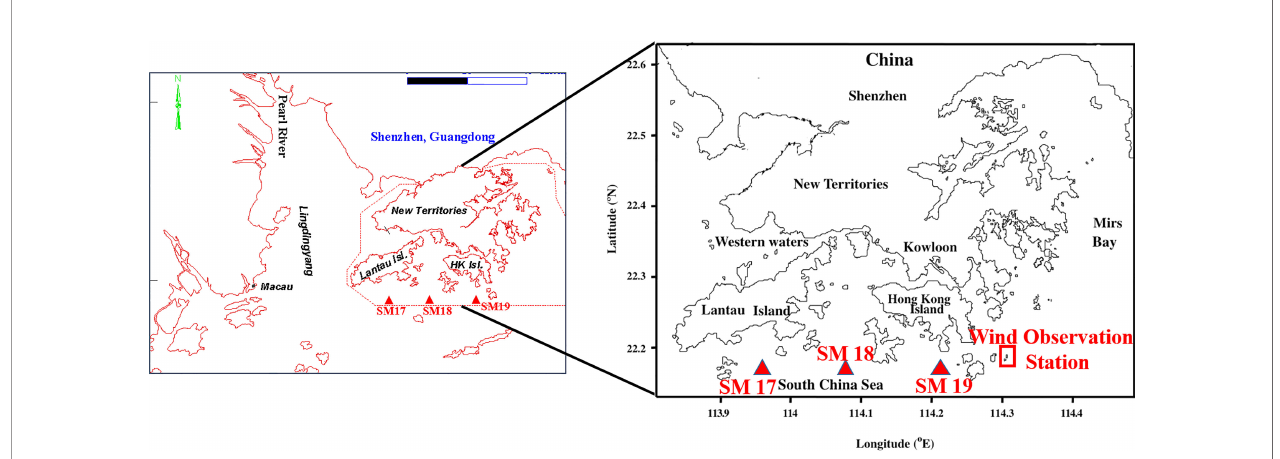
FIGURE 1 | Map of the Pearl River estuary and Hong Kong waters showing the selected EPD water quality monitoring stations (SM17, SM18 and SM 19) and wind observation station in Waglan